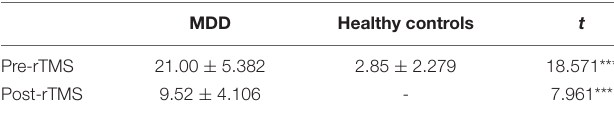
TABLE 2 | Comparisons of the score of HAMD-17 between MDD and healthy controls (mean ± SD ).